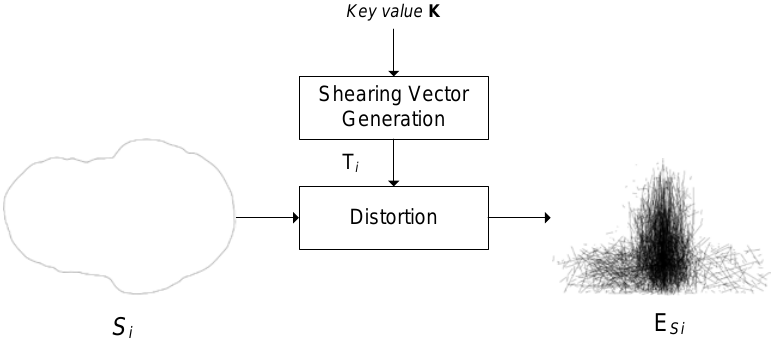
Figure 7. The encryption process of 2D slices in spatial domain.